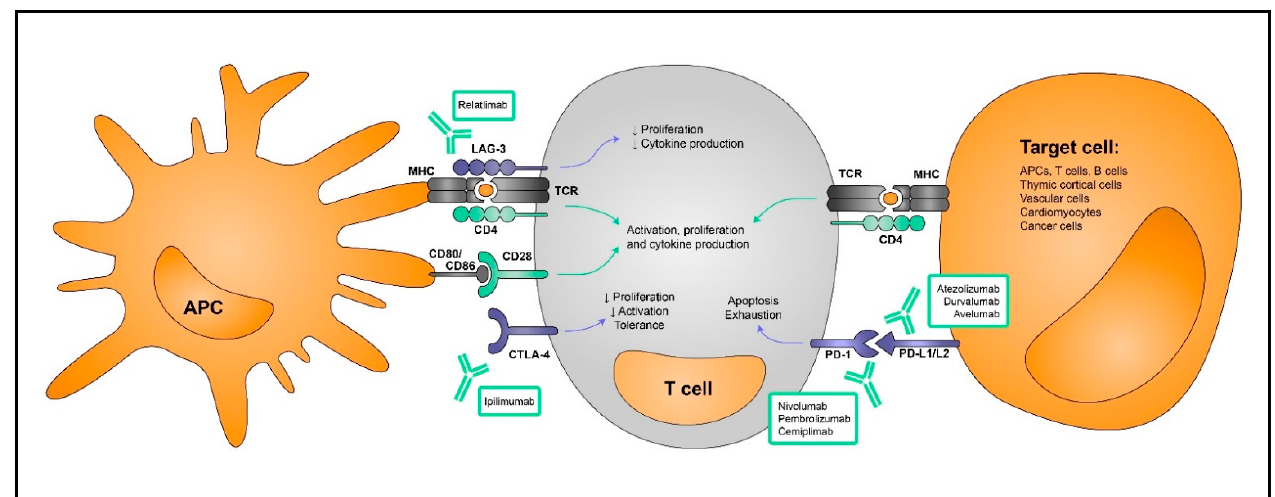
Figure 1. Immune checkpoint molecules. T cells become active upon binding of the TCR to the MHC-antigen complex followed by CD28 co-stimulation both provided by APCs. Both LAG-3 and CTLA-4 limit these interactions via direct competition, hence rendering T cell activation and subsequent proliferation and cytokine production. On the other hand, PD-1 and PD-L1/L2 binding on the target cells also contribute to limit the immune response by induction of apoptosis and exhaustion on T cells. These are also targeted by monoclonal antibodies to enhance immune responses in a cancer setting.